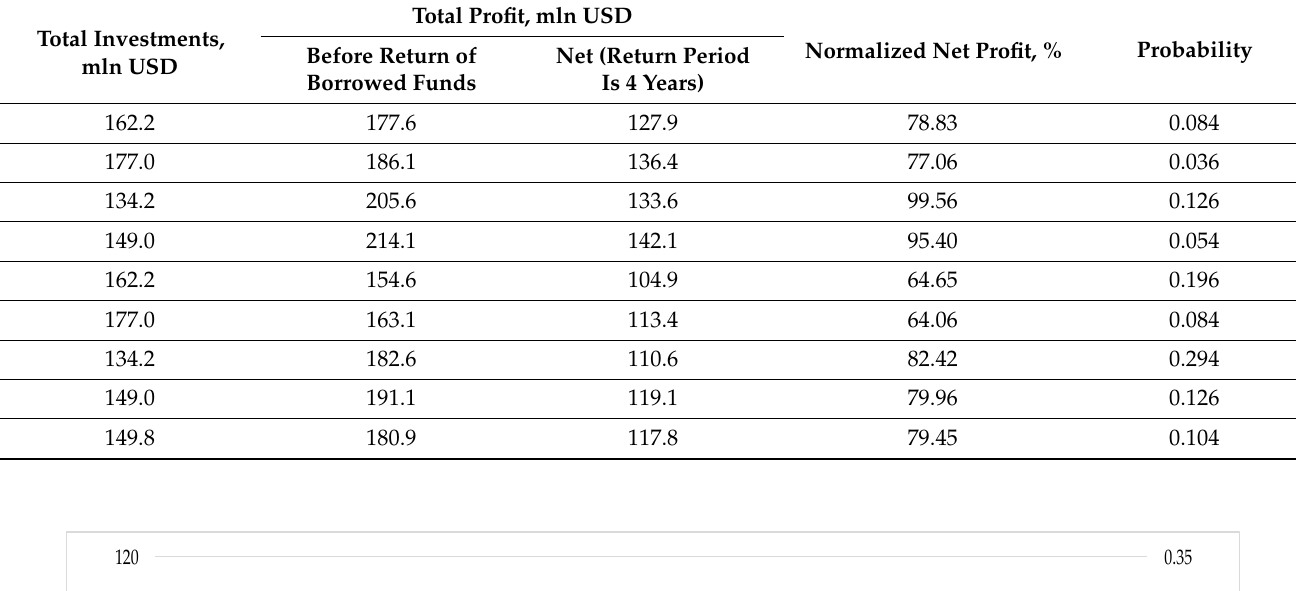
Table 1. Efficiency indicators of RES investment projects and the probability of their implementation.